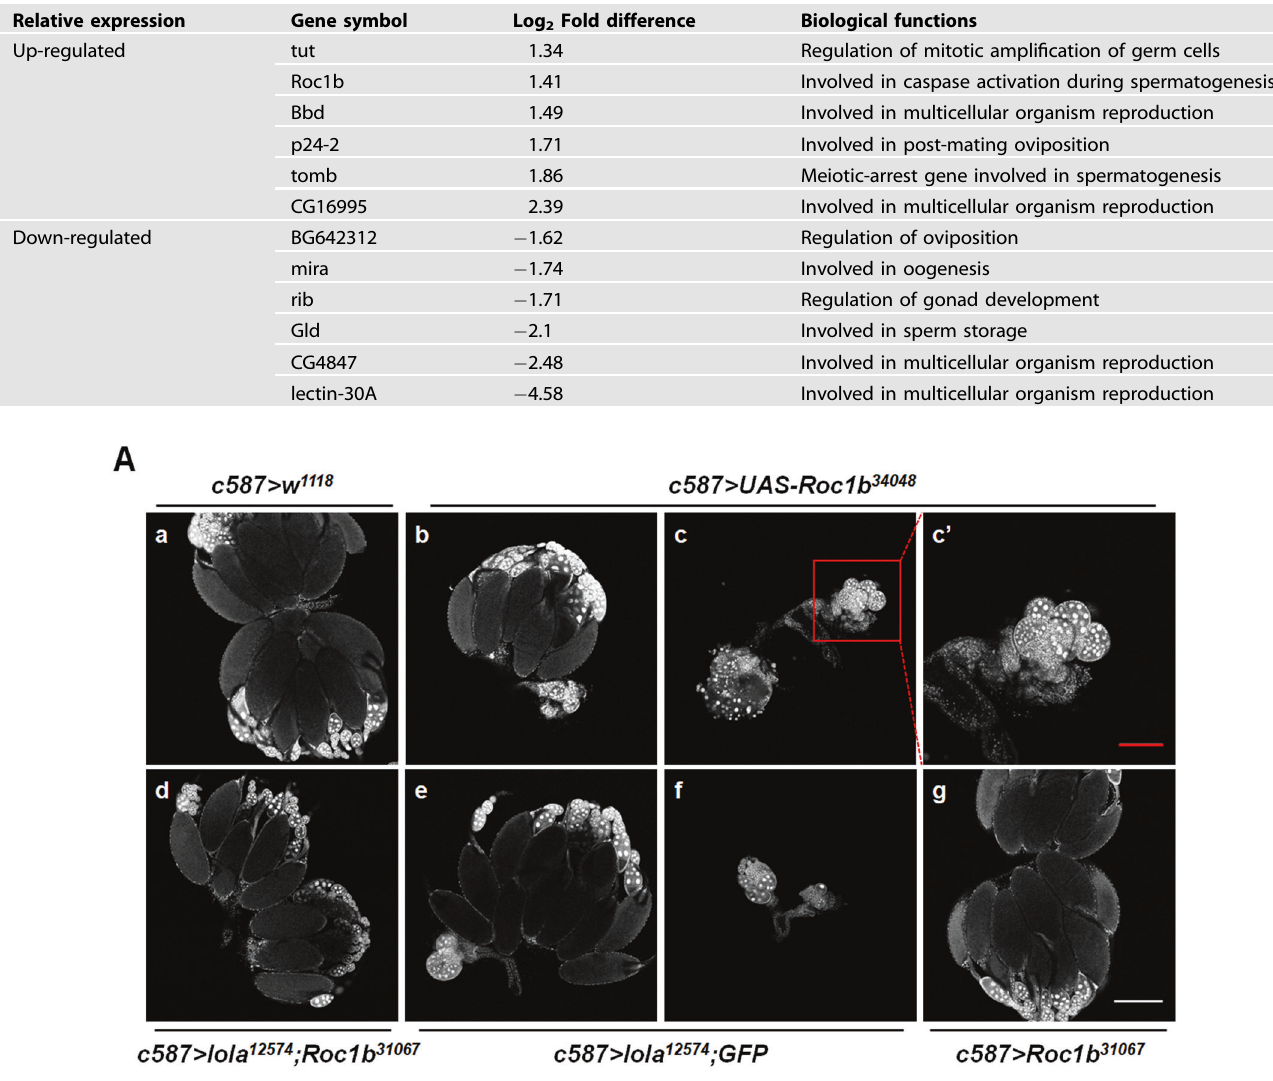
Table 1. Differentially expressed genes selected for qRT-PCR validation.